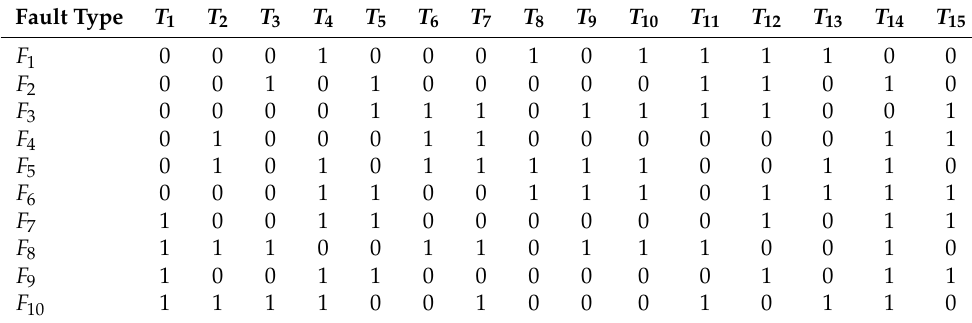
Table 5. Dependency matrix for fault diagnosis adopted from the Apollo system